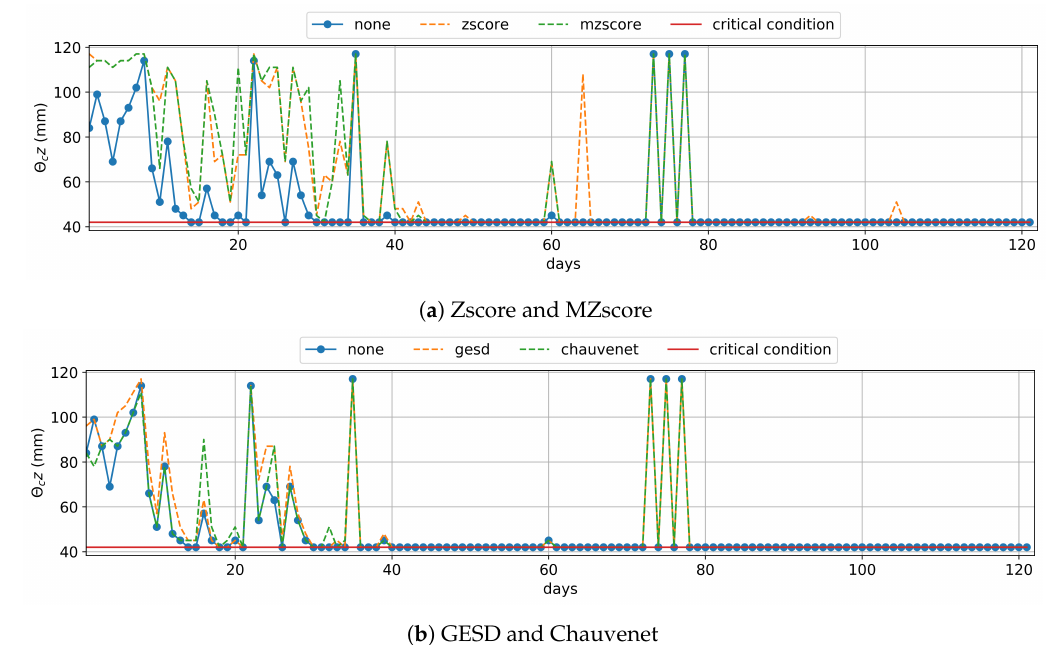
Figure 6. Real Moisture Data used in Matric Potential — the points outside of the dashed lines are soil moisture θ c modified by an outlier removal technique. Irrigation occurs when θ c reaches the critical condition θ cr (red